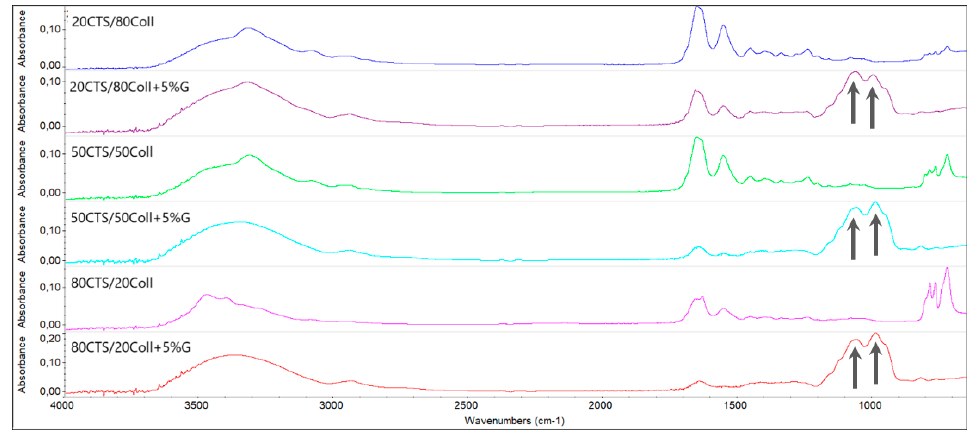
Figure 3. FTIR-ATR spectra obtained for all tested samples where the characteristic peaks are visible upon incorporation of 5% glyoxal (arrows).